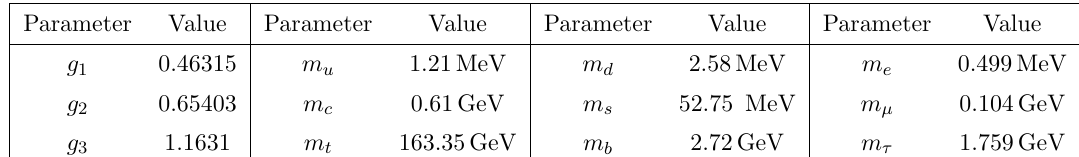
Table 1 . The SM parameters at renormalization scale M details, appendix C of